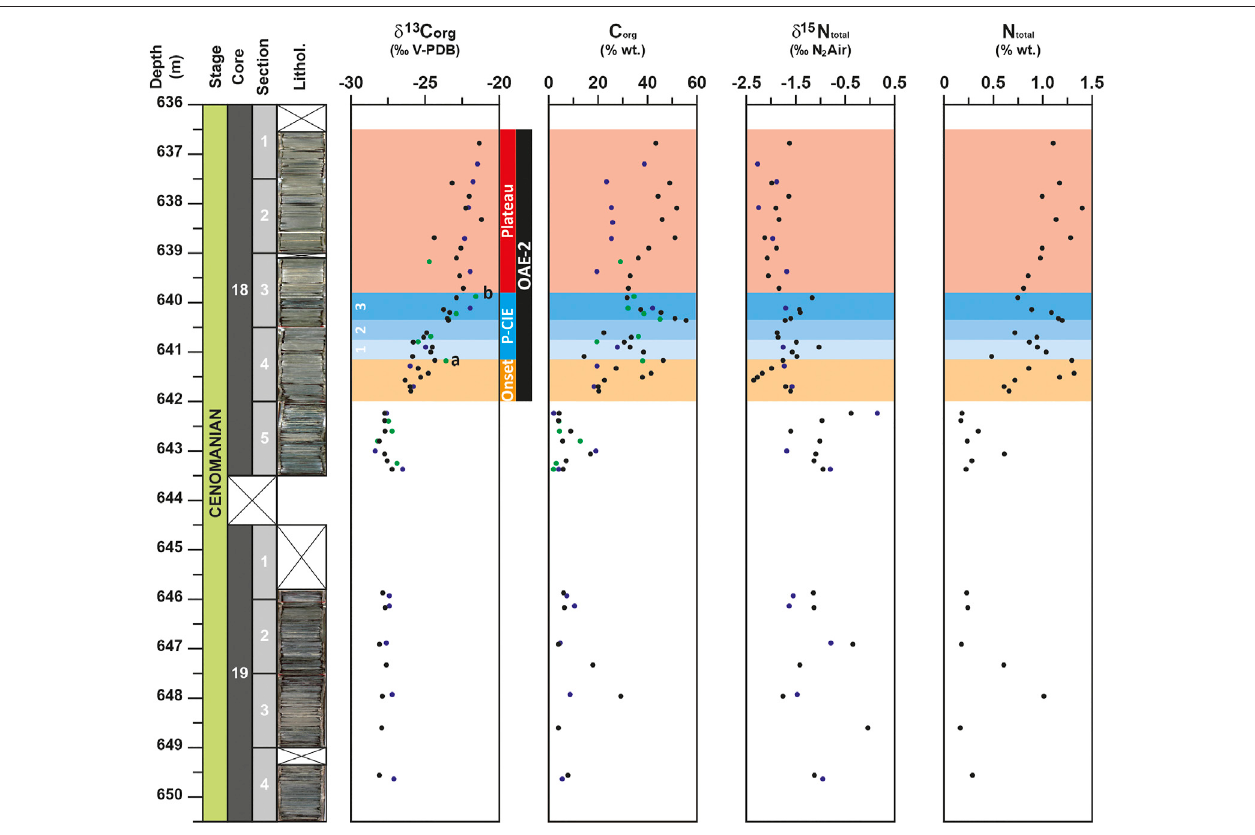
FIGURE 2 | Depth-pro fi les for δ 13 C org , δ 15 N total signals, organic carbon (C org ) and total nitrogen (N total ) contents for the DSDP site 367. Data from the studies of Kuypersetal.(2002)andKuypersetal.(2004)andForsteretal.(2007)arerepresentedwithblueandgreencirclesrespectively.OAE-2intervalisrepresentedbythedark band determined on the base of the positive carbon isotope excursion. The OAE-2 interval is divided in three parts: the onset, represented by the orange band, the Plenus carbon isotope excursion (P-CIE), represented by the blue band and the plateau represented by the red band; a and b would correspond to the δ 13 C carb maxima,de fi nedbyJarvisetal.(2011),thatmarkthelimitsbetweentheonsetandtheP-CIEintervalsandbetweentheP-CIEandtheplateauintervals.TheP-CIEissub- divided in three subparts numbered 1, 2, and 3 and represented by gradual darker blue bands.